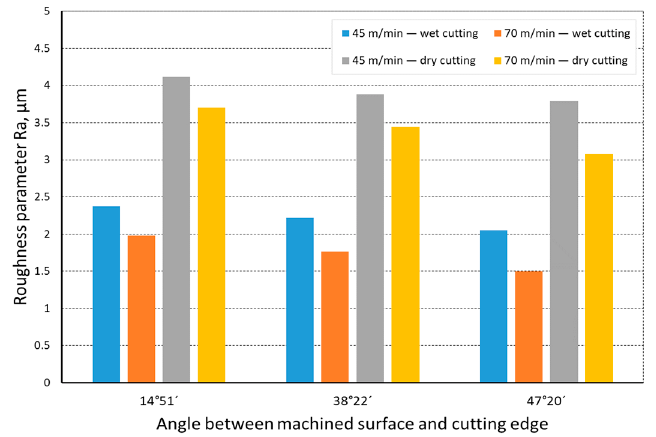
Figure 10. The impact of cutting speed on the variability of roughness parameter Ra in the function of the angle between the machined surface and cutting edge for a curvilinear track and a material hardness of 36 HRC.